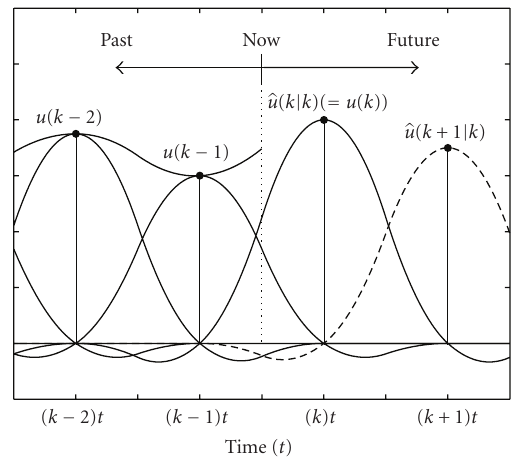
Figure 2: Interpolation based on a 2nd-order spline sampling function using predictive future control